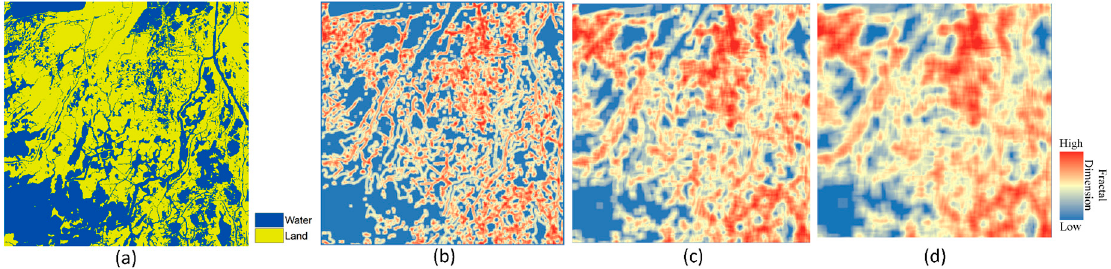
Figure 16: Calculating local fractal dimensions of a land cover raster. ( a ) A binary land cover raster in the wetland in the Mississippi Delta. ( b ) Local fractal dimension of the land cover data in a 11 × 11 cells moving window. ( c ) Local fractal dimension in a 21 × 21 cells moving window. ( d ) Local fractal dimension in a 31 × 31 cells moving window.